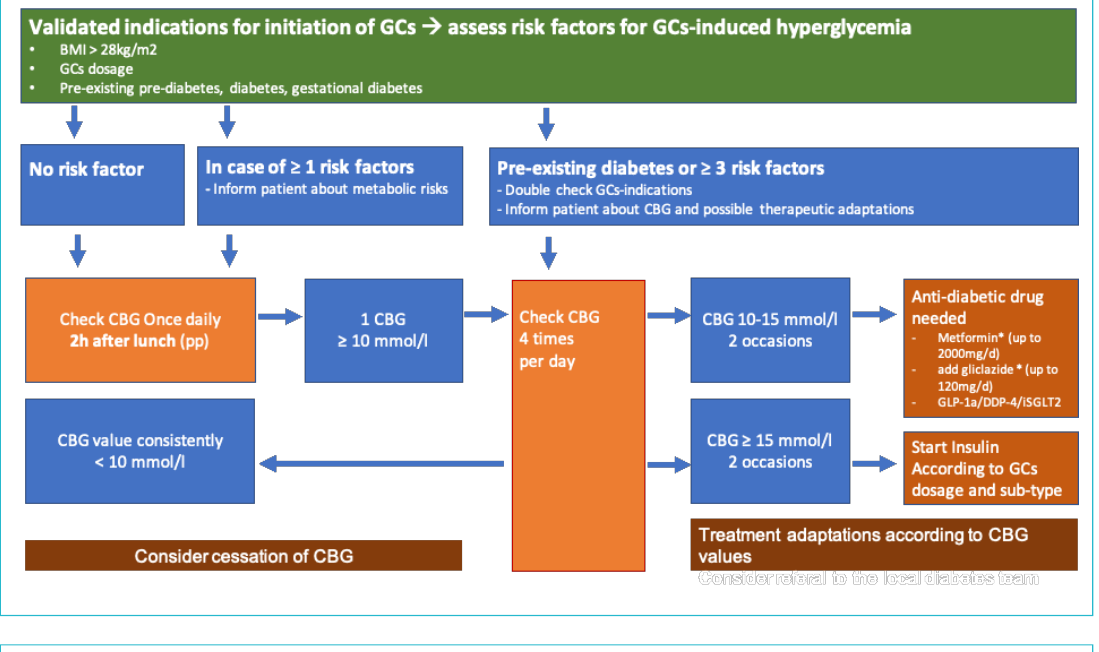
Figure 2: Suggestions for iInsulin initiation according to glucocorticoid dosage and subtype. CBG: capillary blood glucose; NPH: neutral prota- min